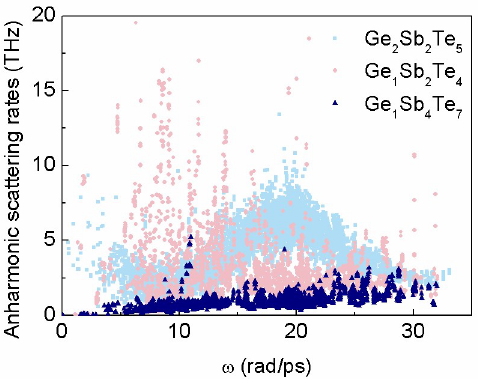
Figure 4. Anharmonic scattering rates for h -GST phases at 300 K vs. angular frequency.